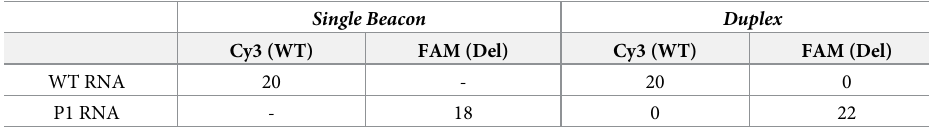
Table 4. Dual-beacon RT-LAMP for variant RNA